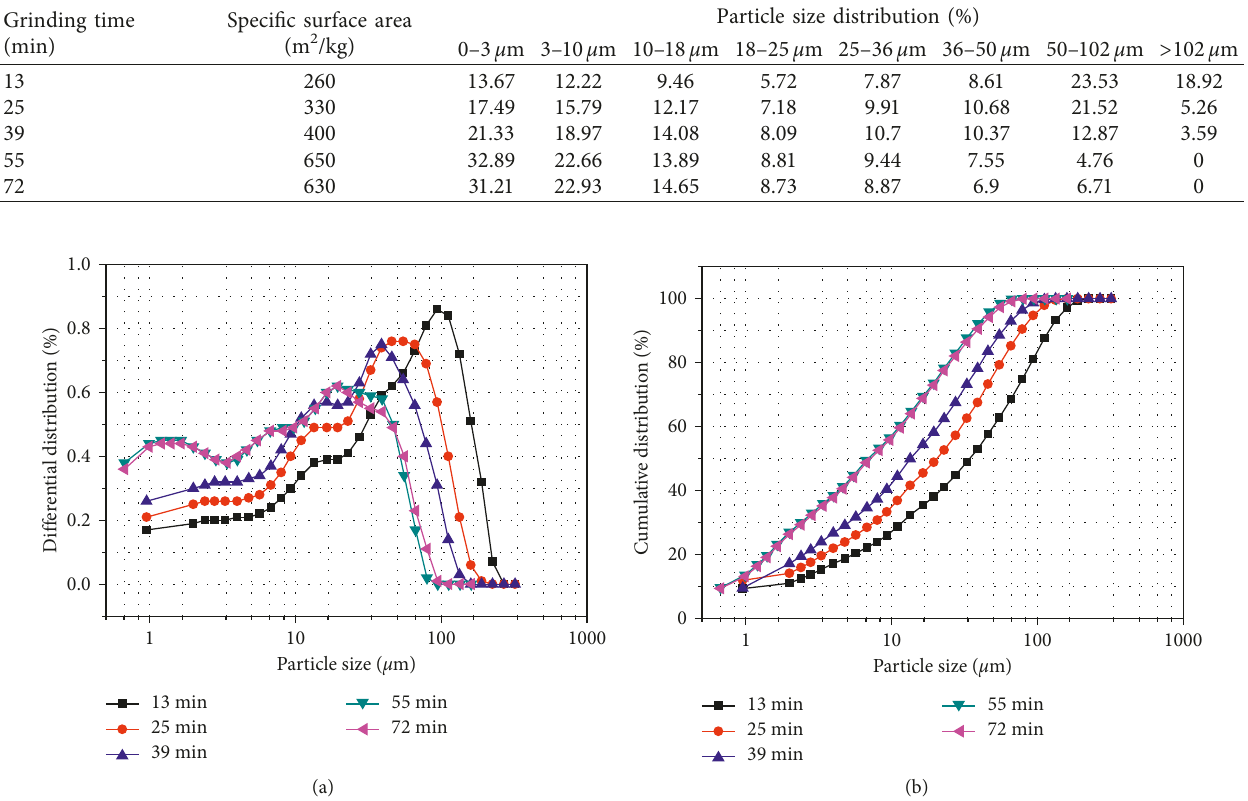
Figure 2: Differential and cumulative particle size distribution of CFBC desulfurization slag.